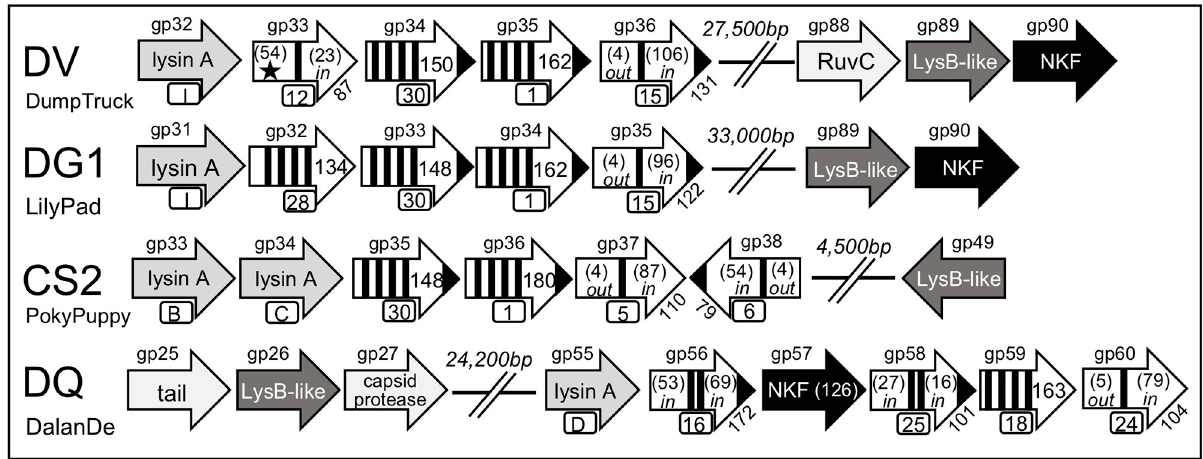
Fig 9. Genomic organization a lysis cassettes with a lysA and four transmembrane genes and a predicted lysB at a distal location. The genomic structure is shown and the key to the schematic is presented in Fig 1. The direction of transcription of each gene is represented by the arrowhead.